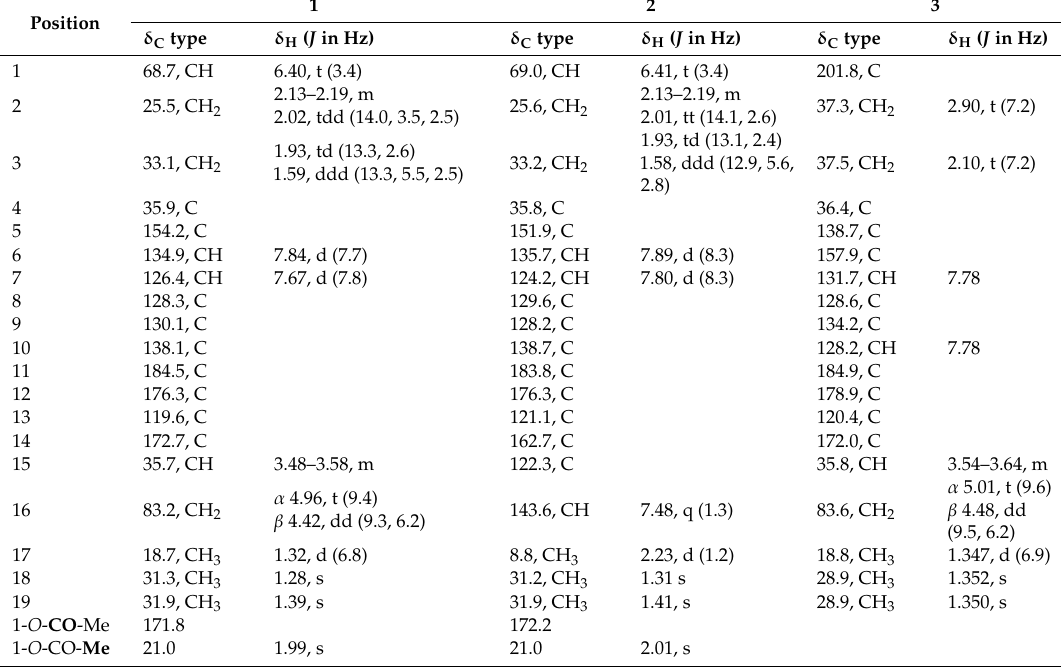
Table 1. 1 H (500 MHz) and 13 C (125 MHz) NMR data of 1–3 in methanol- d 4 ( δ in ppm, J in Hz) *